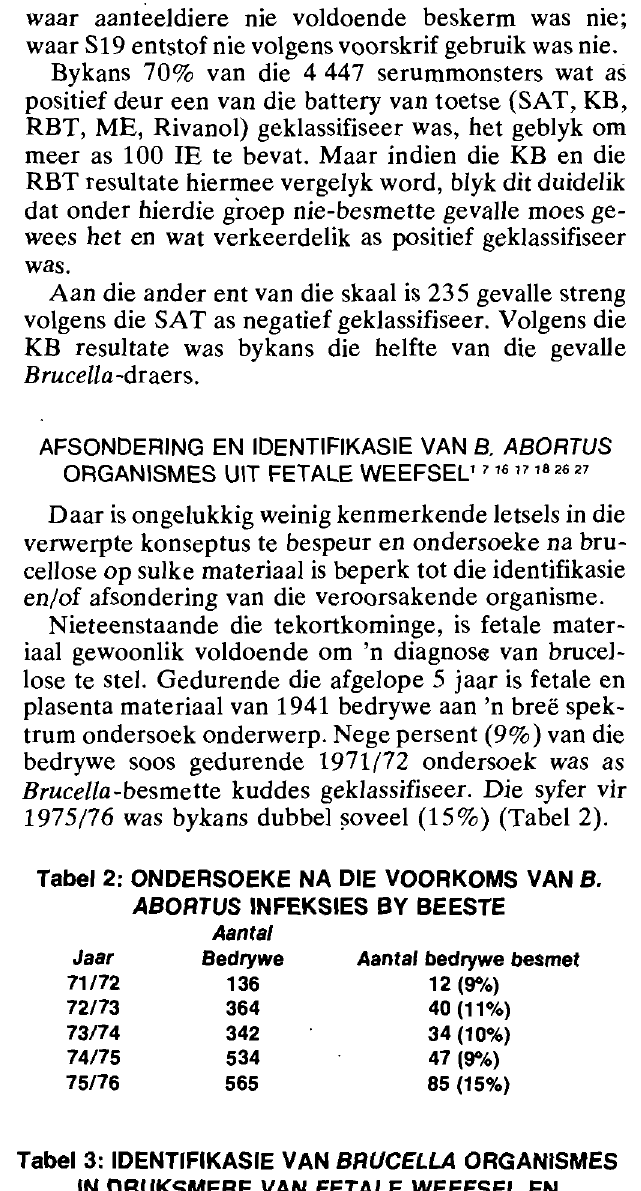
Tabel 3: IDENTIFIKASIE VAN BRUCELLA